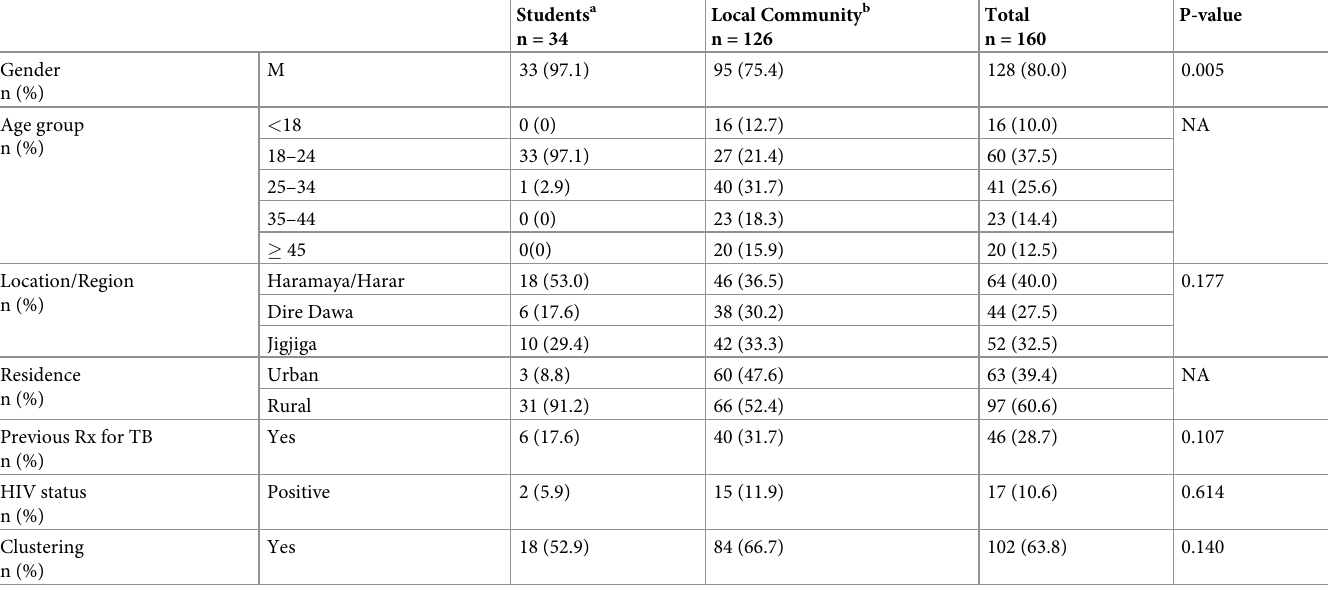
Table 1. Characteristics of university students and members of the surrounding community diagnosed with pulmonary tuberculosis, Eastern